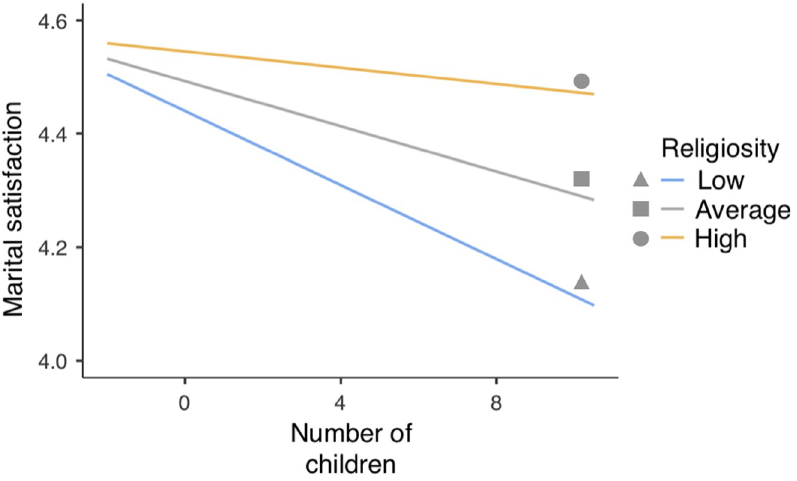
Fig 4. Interaction of the number of children and sex in relation to marital satisfaction